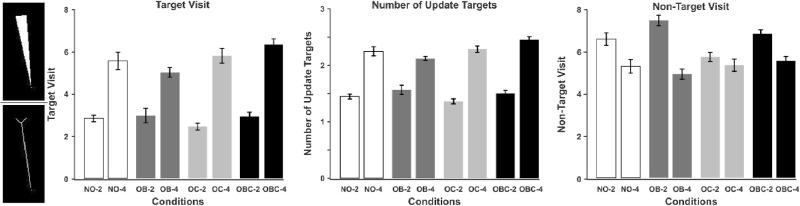
The left-most part of the figure shows a sample larva's skeleton (bottom) made from its minimal bounding polygon (top). The left, middle, and right panels depict average number of target visits, updated targets and nontarget visits, respectively. OB = object-object occlusion; OC = object-occluder occlusion; OBC = object-object + object-occluder occlusion. Error bars show standard error of mean.